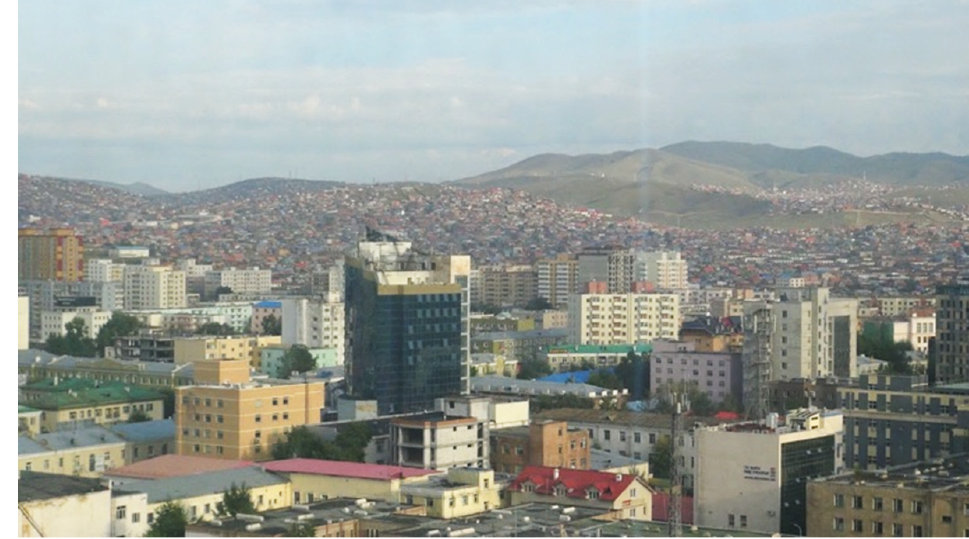
Figure 2. A view from the Ulaanbaatar city office, looking at the apartment and ger areas. Table 1. Reviewed documents regarding urban green space policy in Mongolia and Ulaanbaatar city. Documents